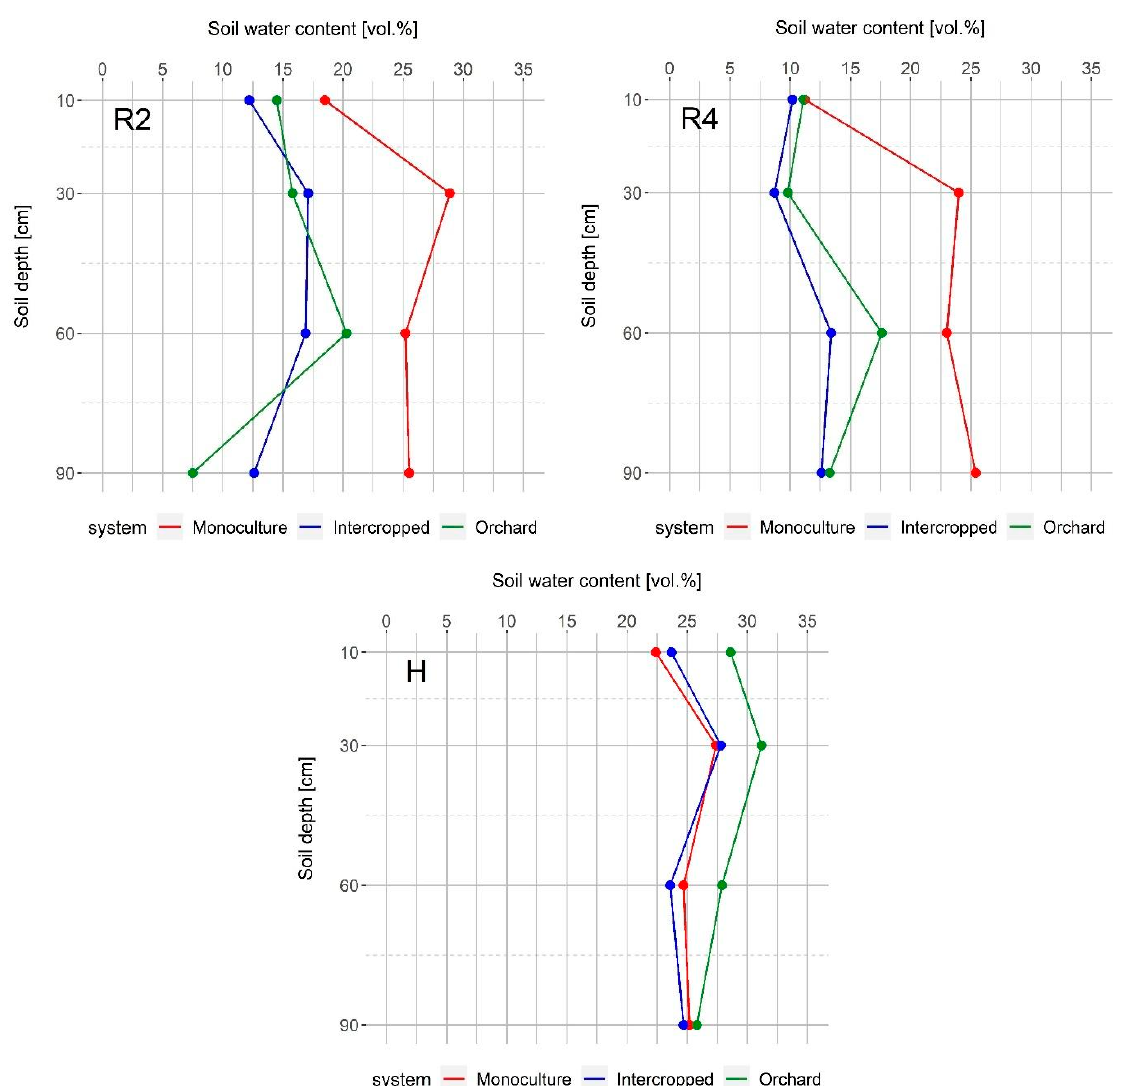
Figure 4. Soil volumetric water content in the monoculture and intercropped systems, and the walnut orchard during: S—maize sowing date; V5—five leaves stage; R2—blister stage; R4—dough stage; H—harvest. Data show average values for the 10-day recording period.